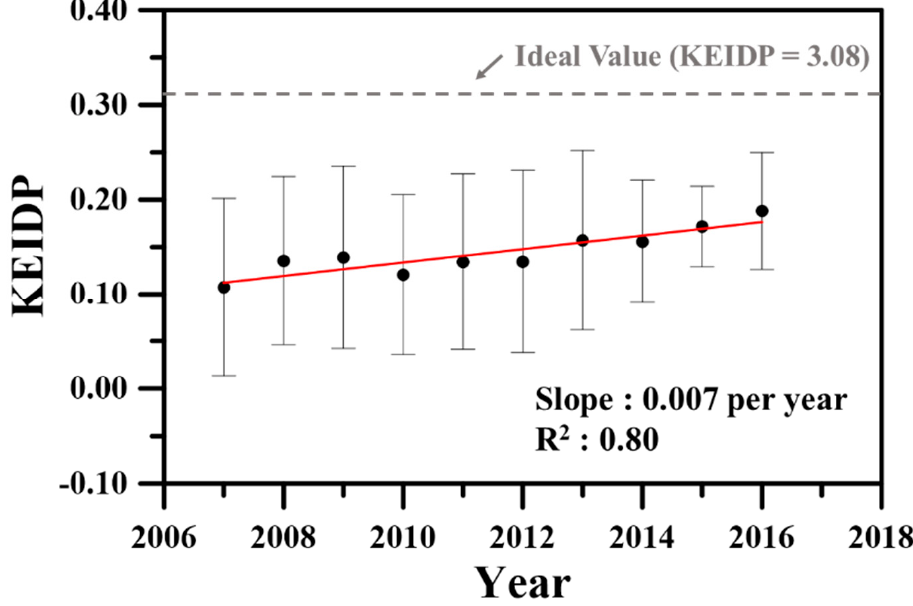
Figure 5. Development projects trend calculated using the MLP based ANN model with EIA Big Data for all 611 projects.